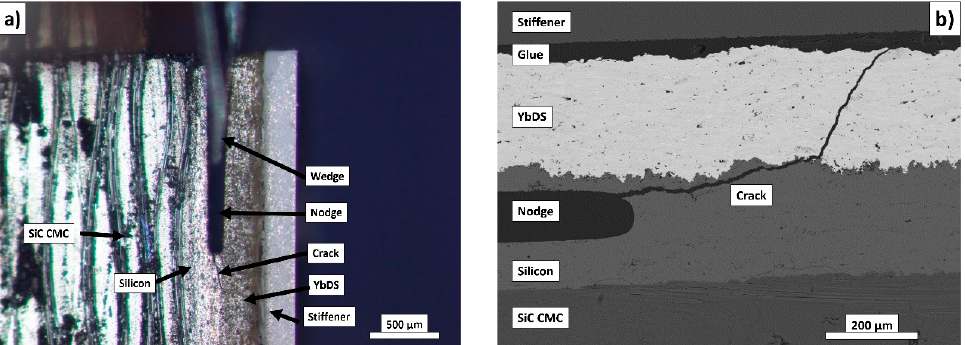
Figure 9. Macrocopic ( a ) and microscopic ( b ) pictures of a testes sample with attached stiffener. The Young’s moduli E ’ A with 380 GPa and E ’ B with 126.37 GPa for the alumina stiff-